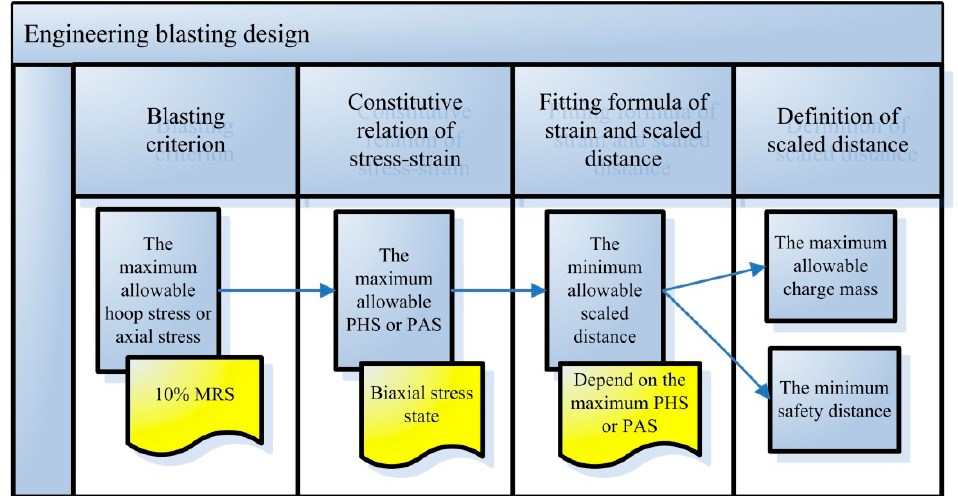
Figure 19. The flow chart of engineering blasting design.